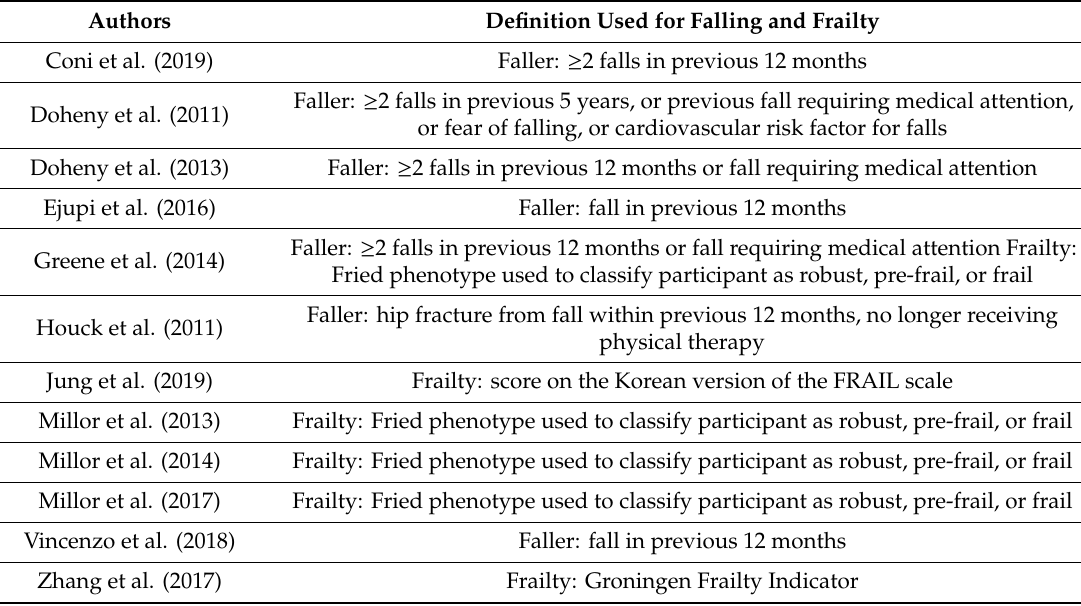
Table 2. Definitions used for fallers and